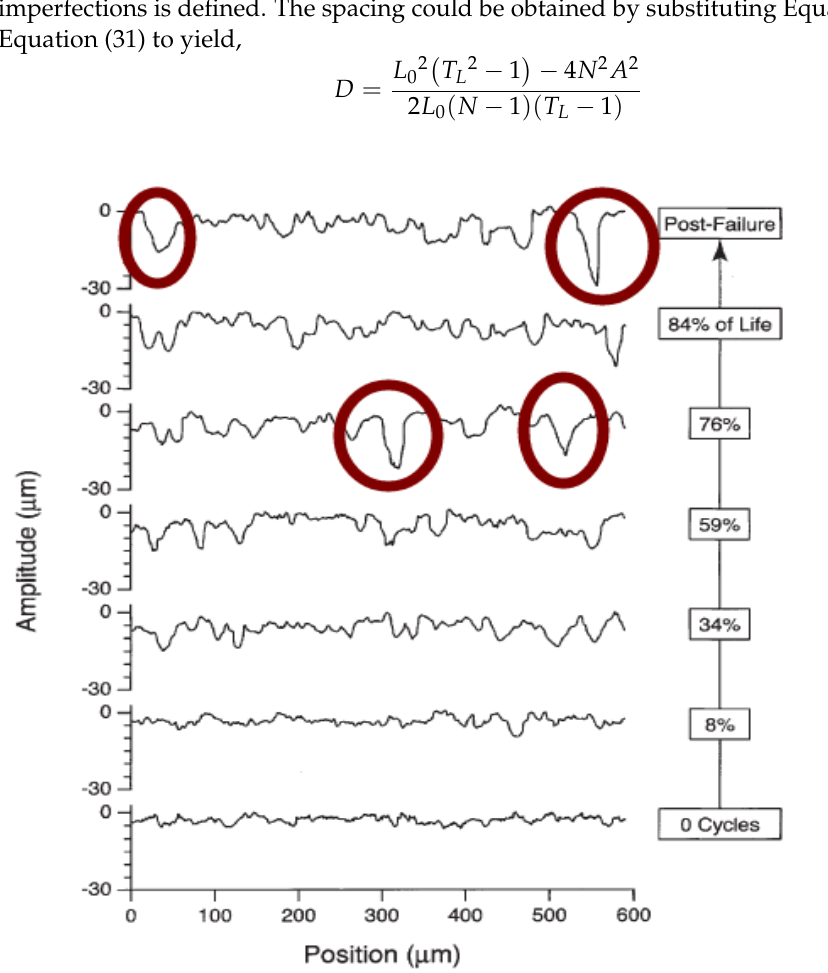
Figure 31. Profiles of the metal/oxide interface extracted from cross-sectional images at various stages of thermal cycling, illustrating the continuous evolution of interface morphology during cyclic exposure.